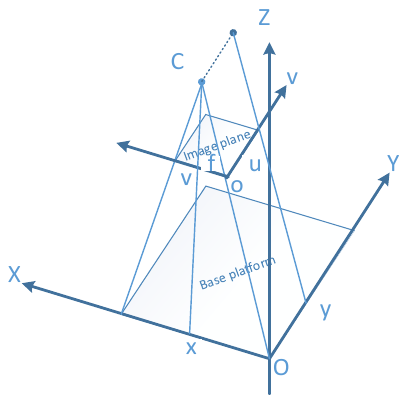
Figure 4. The imaging principle of the pushbroom camera model. The hyperspectral camera with focal length f and camera center C. The image coordinate is o-uv, while the system 3D coordinate is O-XYZ. The object point in X axis is projected to the image coordinate v, while the object point in Y axis is projected to the image coordinate u.